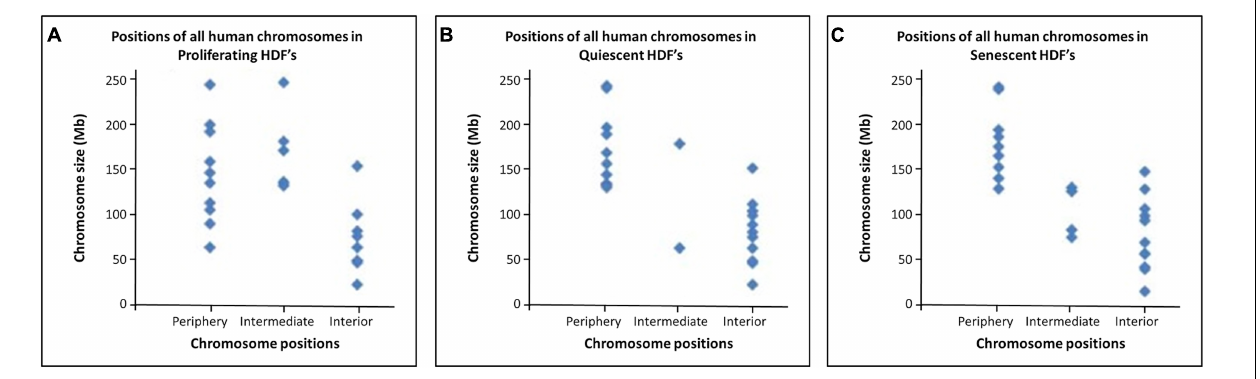
FIGURE 3 | Relationship between chromosome size and nuclear location within proliferating, quiescent and senescent HDFs: The size (Mb) of each chromosome falling within a positioning category (nuclear periphery, at an intermediate location, or in the nuclear interior) in proliferating, quiescent and senescent cells are displayed in panels (A–C) ,